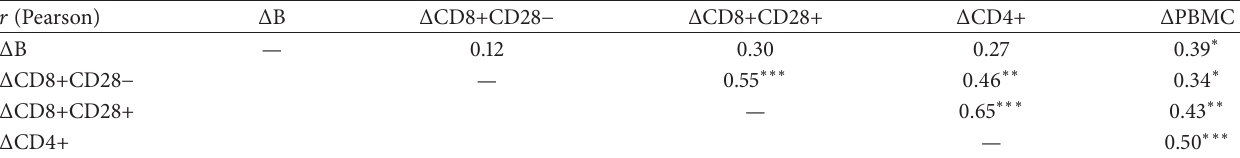
Table 4: Correlation of telomere length change among different cell types (with correction for regression-to-the-mean (RTM)). 𝑟 (Pearson)